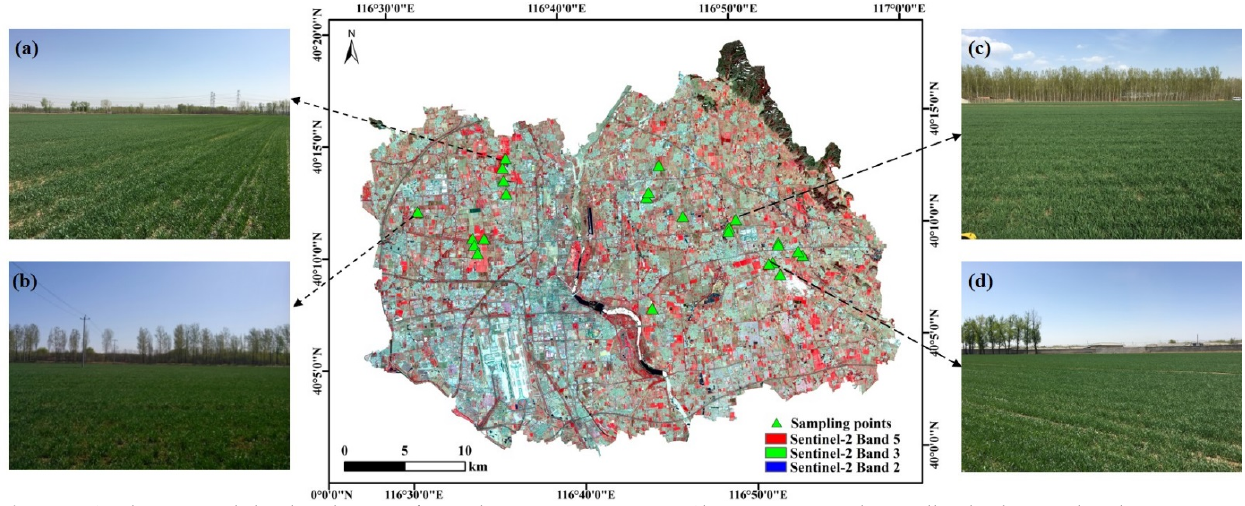
Figure 1. Study sites and the distribution of sampling points in Beijing, Shunyi District. The satellite background is the border of the Shunyi district. ( a – d ) are photos of sampling points No. 20, No. 16, No. 9, and No. 4 at the early jointing stage. Table 1. Sample plots at four growth stages.